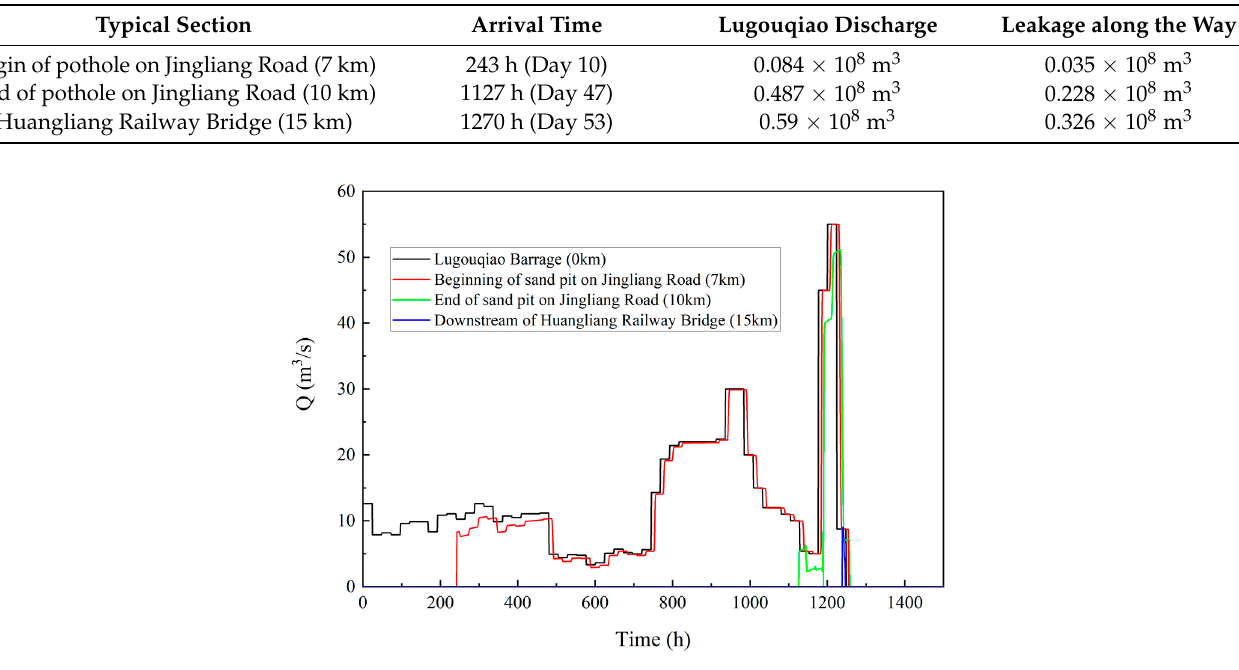
Figure 6. Flow process diagram of typical sections in the southern plain reach of the Yongding River in 2019.